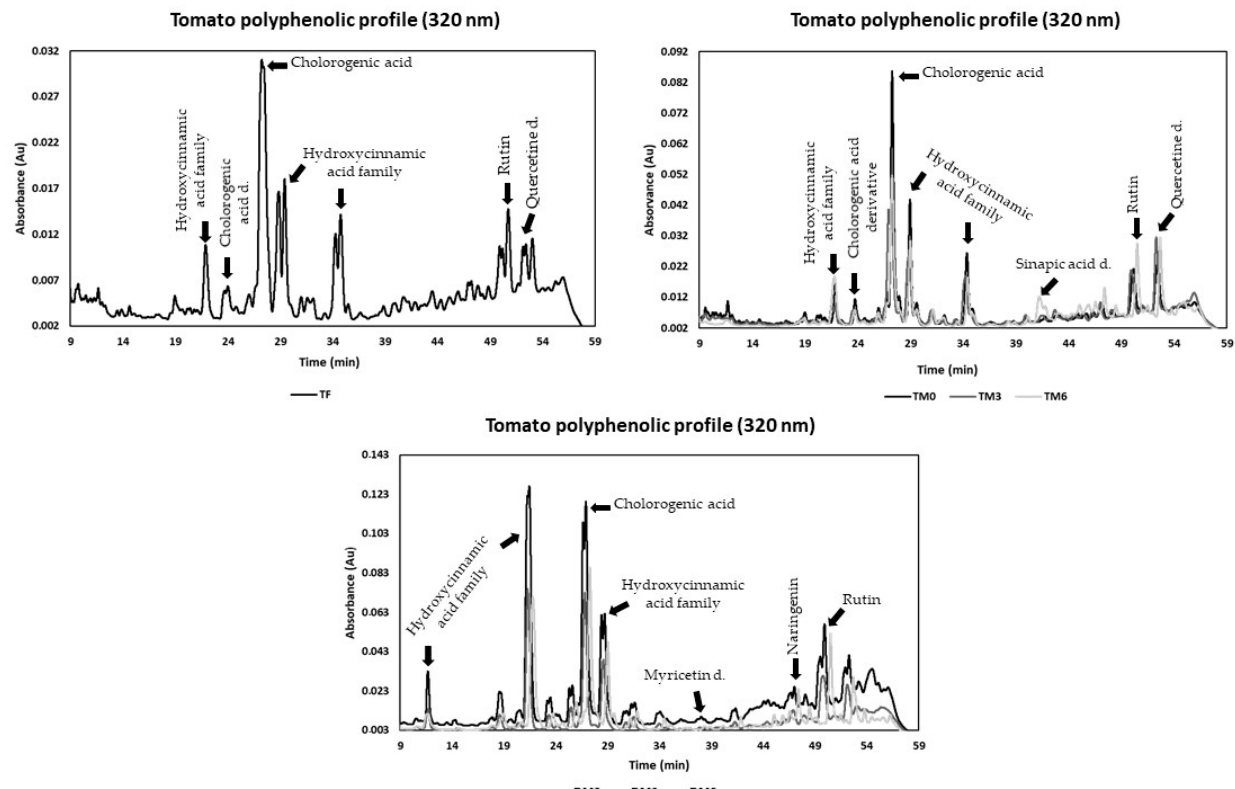
Figure 2. Chromatograms of identified free phenolic compounds of ( a ). fresh tomato by-products and during ( b ). the freezing pulps and ( c ). drying storage of powders at a wavelength of 320 nm. TF = fresh tomato. TM0 = 24 h after the freezing storage of tomato pulp. TM3 and TM6 = month three and six of the freezing storage of tomato pulps, respectively. DM0 = day 0 of the tomato powders storage. DM2 and DM6 = month two and six of the storage period of tomato powders.